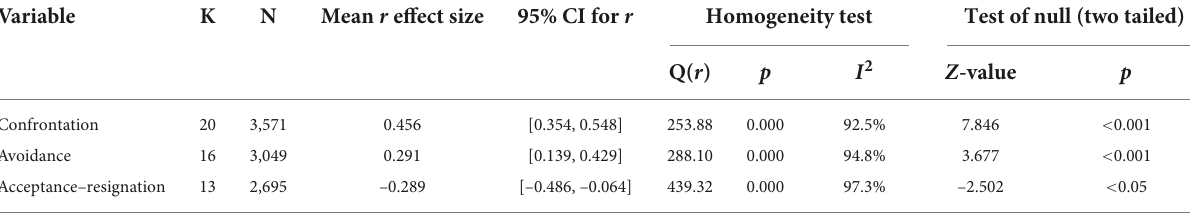
TABLE 2 Random effects model of the relation between posttraumatic growth (PTG) and coping styles. Variable